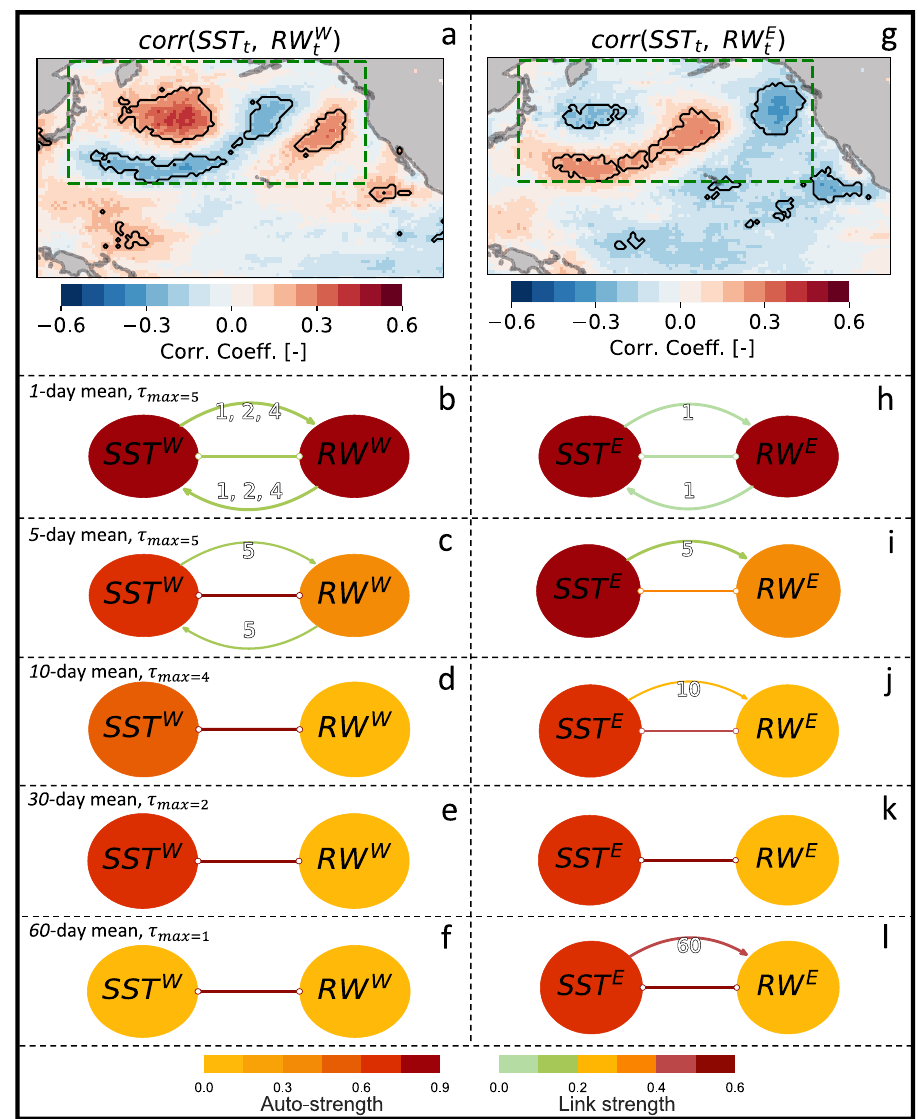
Fig. 2 Quantifying SST-RW coupling at different timescales in summer. Panel ( a , g ): lag 0 correlation maps of SST versus the western (eastern) RW timeseries. Panels ( b – f ) and ( h – l ): CENs between the respective SST pattern timeseries and the RW pattern timeseries for different temporal aggregations [1, 5, 10, 30, and 60]. The Link strength (link color) shows the MCI value (mean over signi fi cant links), which is the correlation strength, after removing the information of the parents of both variables. The Auto-strength (node color) shows the autocorrelation after regressing out the in fl uence of its parents. The link labels indicate at which lags [in days] there was a causal link. CEN link is only plotted if they are signi fi cant at least 60 out of 70 perturbation experiments, similar for the indication of signi fi cance in panel a and g by black contour